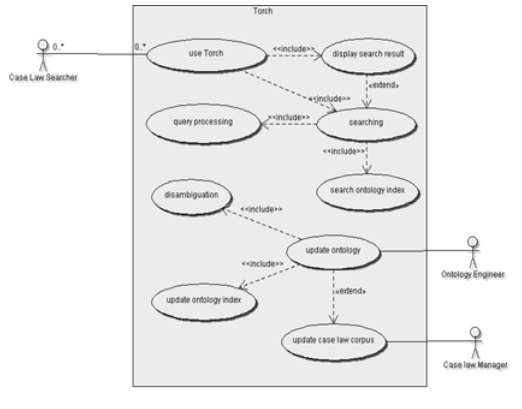
Fig. 2. Use case diagram for the Law-Torch system.